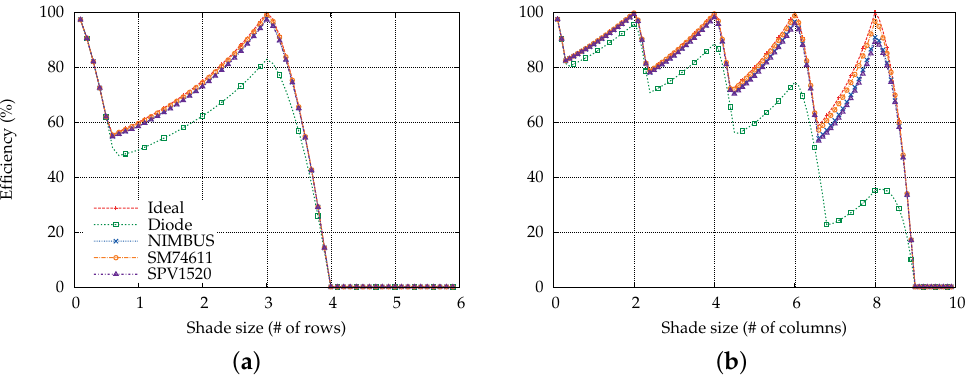
Figure 13. Efficiency comparison between the different bypass elements (ideal bypass, diode bypass, NIMBUS (10 m Ω ), SM74611 (Texas Instruments, 3.5 m Ω [20]), SPV1520 (STmicroelectronics, 12 m Ω [21])) under different shading scenarios: ( a ) horizontal and ( b ) vertical. Values in between the natural numbers on the x axis denote the shading intensity of the next row or